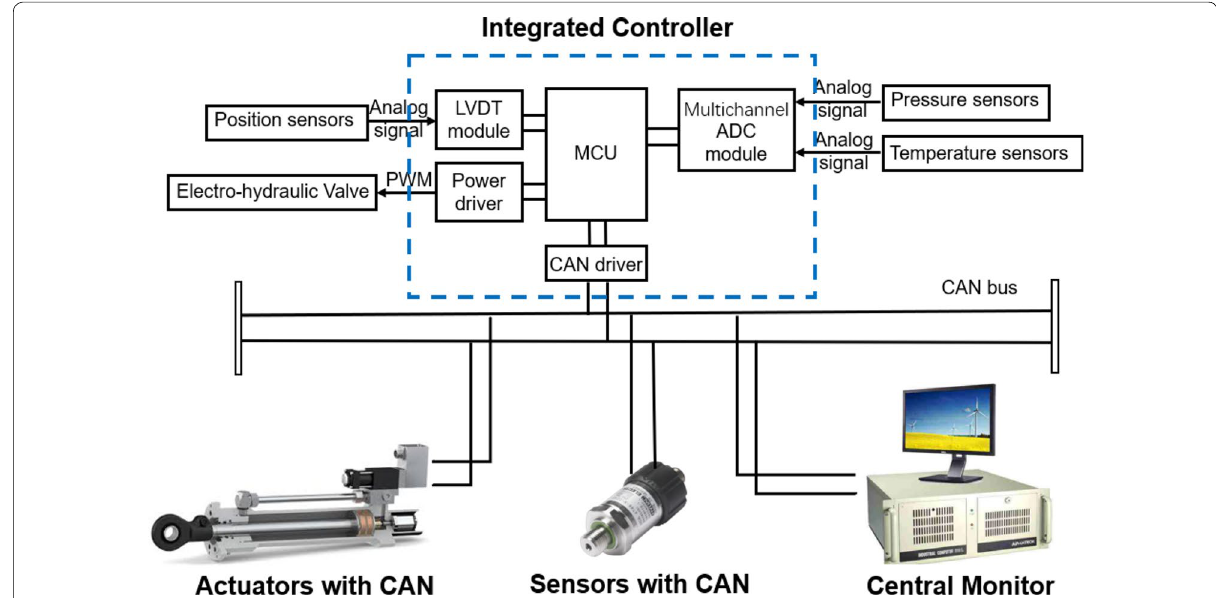
Figure 14 Communication structure of the control system connected by the CAN bus